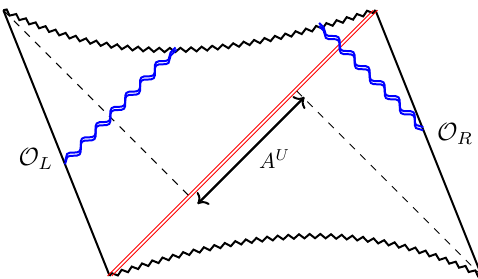
Figure 7. Positive-energy shock wave geometry produced by the backreaction of the signal, which is introduced by the operator ψ L . The negative-energy shock wave produced by the operator O R suffers a time delay as it crosses the